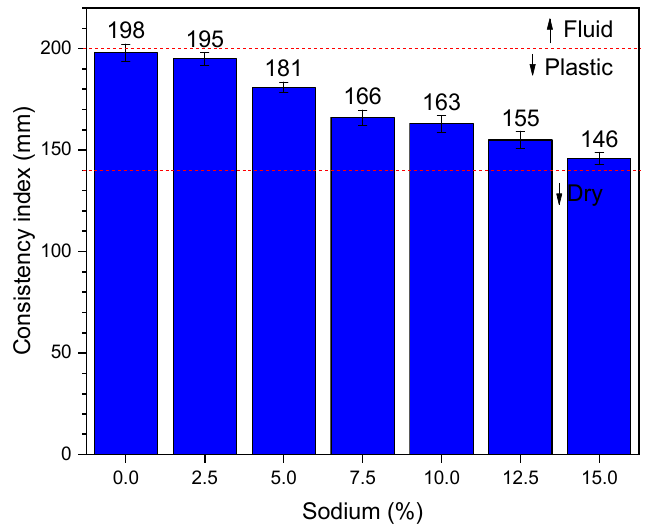
Figure 2. Consistency index results.